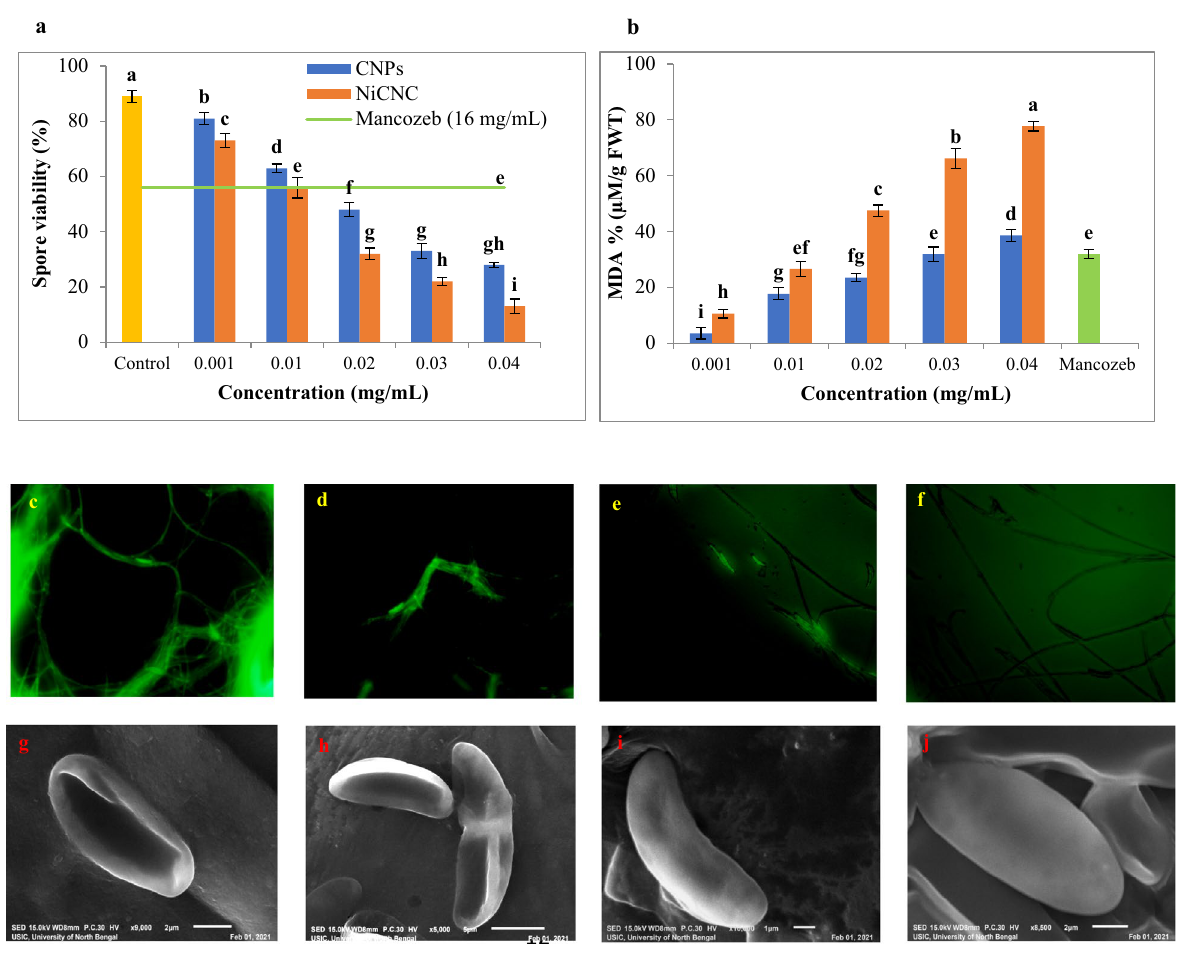
Figure 5. Effect of different concentrations of CNPs and NiCNC on ( a ) spore viability percentage and ( b ) MDA percentage of F. solani ; Fluorescence microscopic observations showing generation of oxidative stress in F. solani conidia and mycelium due to the effect of ( c ) NiCNC (0.04 mg/mL), ( d ) CNPs (0.04 mg/mL), ( e ) Mancozeb (16 mg/mL) and ( f ) untreated mycelium; morphological changes of F. solani conidia directly exposed to ( g ) NiCNC (0.04 mg/mL), ( h ) CNPs (0.04 mg/mL), ( i ) Mancozeb (16 mg/mL) and ( j ) distilled water observed under scanning electron microscope.